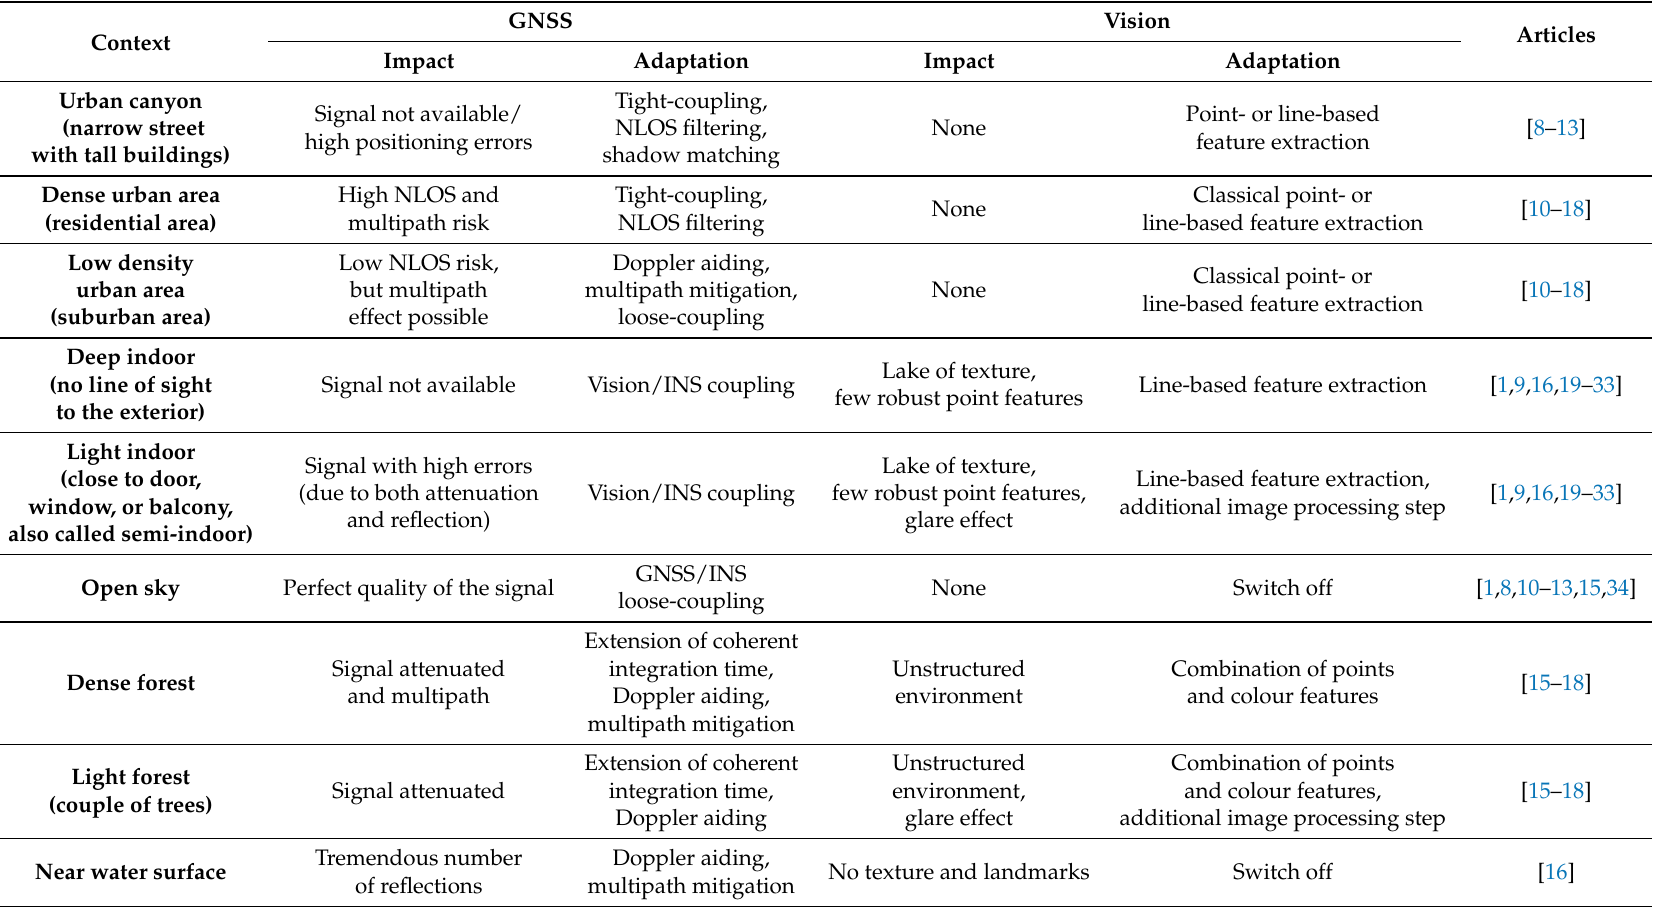
Table 1. List of the environmental contexts of interest, their impacts on GNSS/vision sensors, and the corresponding